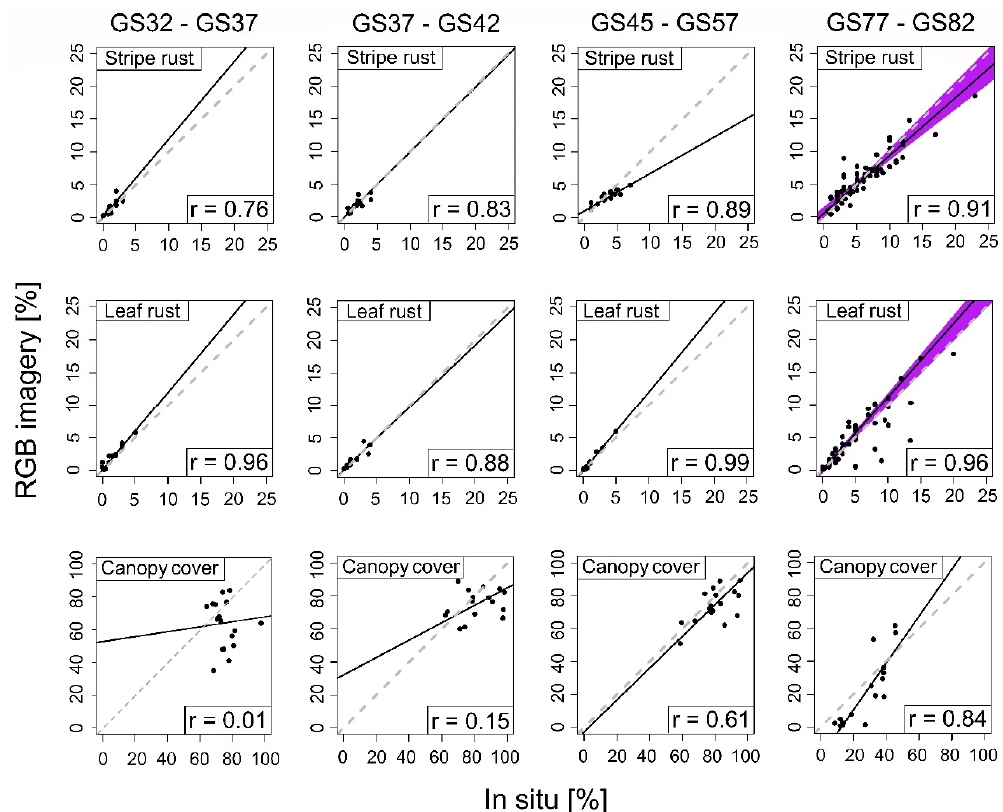
Figure 8. Relationships between the Red-Green-Blue (RGB) imagery-derived estimates and observed values of wheat strip rust severity ( top ), wheat leaf rust severity ( middle ), and canopy cover ( bottom ) for four different growth stage (GS) intervals. Data from the four dates of image acquisition were pooled. The black and dashed-grey lines indicate the deming regression fit and 1:1 lines, respectively. The purple area is the 95% confidence interval of the deming regression fit (the latter is only shown when the number of observations is equal to or more than 20). The detailed results of the statistical tests are presented in Table 3. (Note the differences in scale for the canopy cover). Table 3. Statistics comparing the relationships between the Red-Green-Blue (RGB) imagery-based estimates and observed values. GS refers to the plant growth stage. The correlation coefficient (r), the p -value of the statistical F-test ( p -value (F-test)), the non-parametric Kendall’s rank correlation tau ( τ ), and the p -value of Kendall’s rank correlation tau test ( p -value (Kendall)) are presented. Statistics